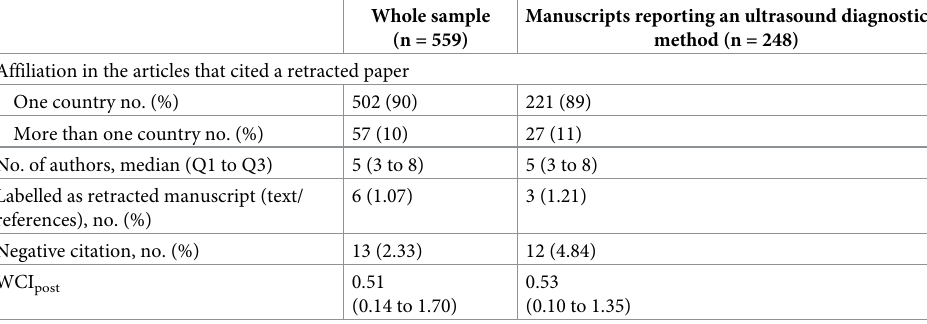
Table 2. Post retraction citations: Characteristics.